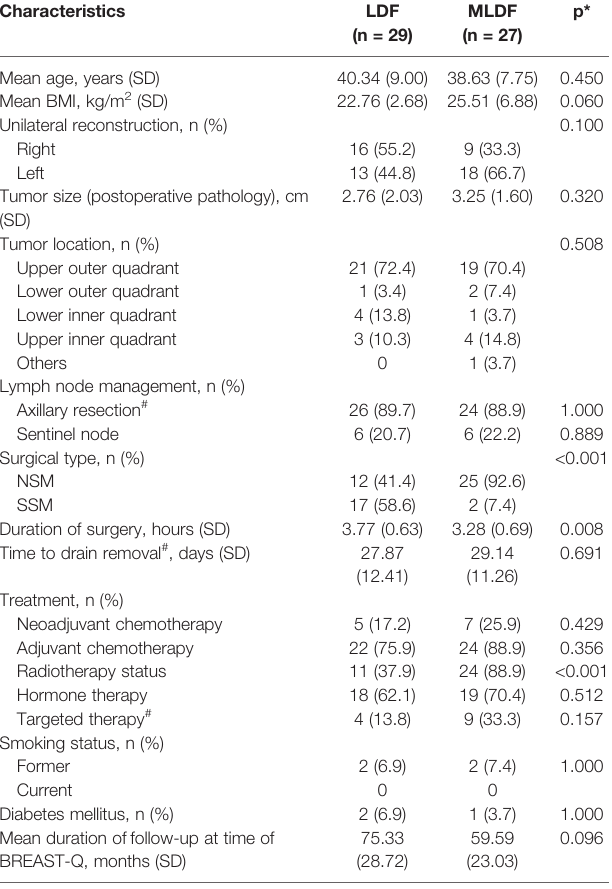
TABLE 1 | Baseline characteristics of the included patients who received LDF or MLDF breast reconstruction. Characteristics